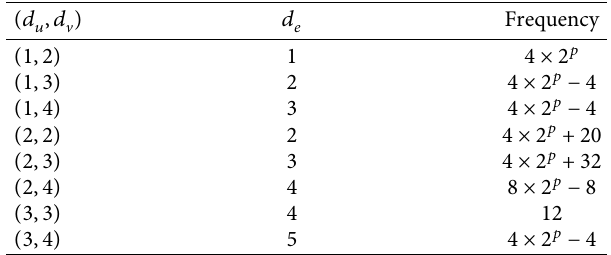
Table 3: Partition of the edges of D